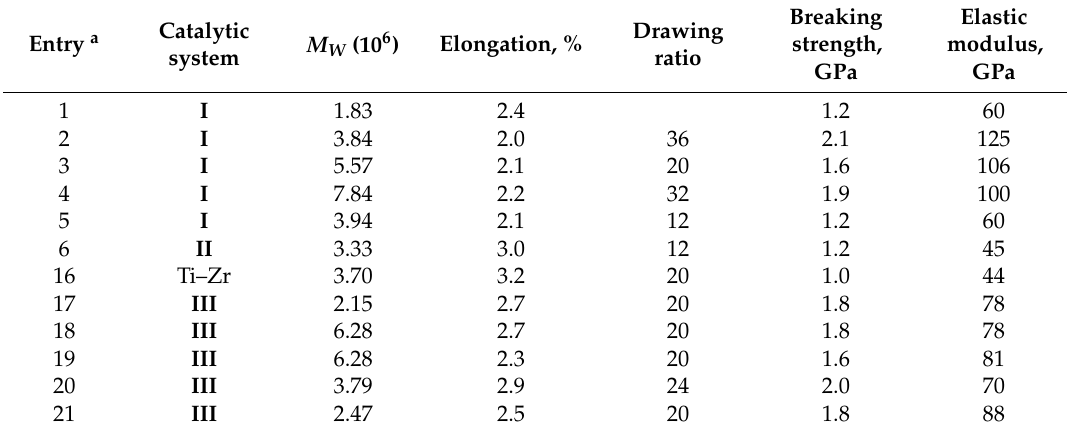
Table 2. Mechanical properties of monolithic UHMWPE tapes.